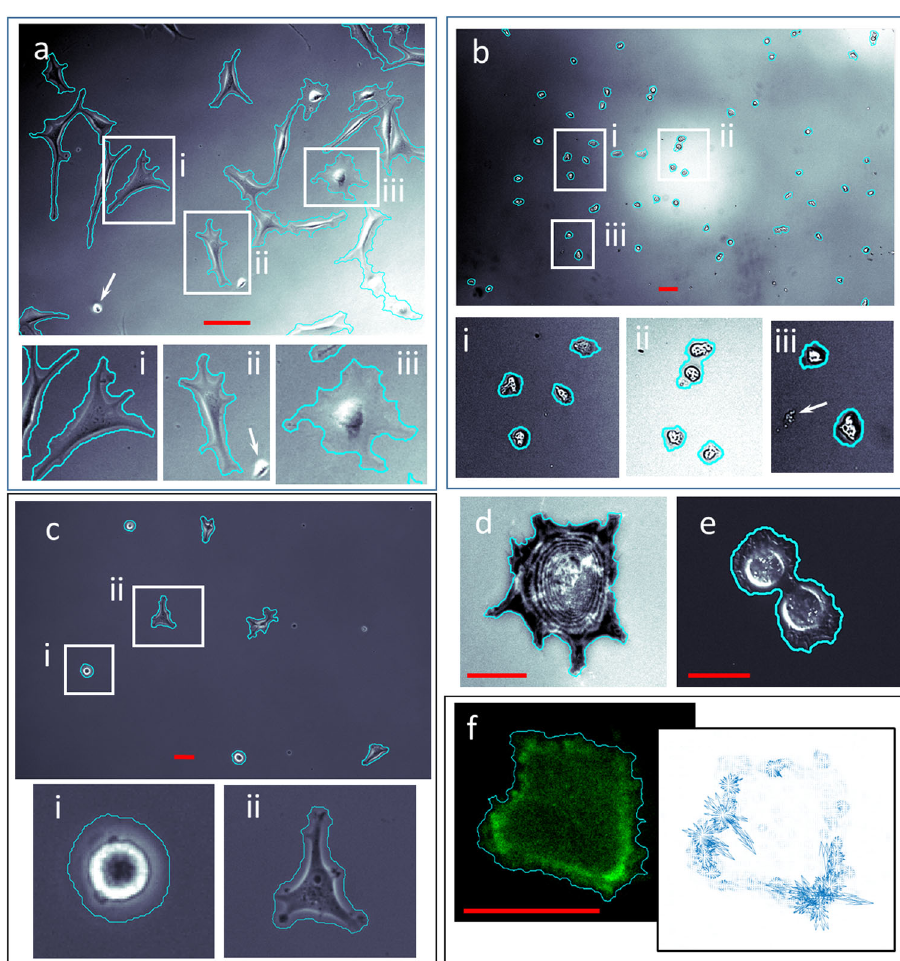
Fig. 3 Self-supervised segmentation for a range of cell types, microscope modalities, time resolutions and magni fi cations. a phase contrast of Hs27 fi broblasts (10X objective, time increment: 1200 s) b transmitted light of Dictyostelium (10X objective, time increment: 60 s) c phase contrast of MDA- MB-231 (10X objective, time increment: 600s) d IRM image of a single Hs27 cell (40X objective, time increment: 600 s). e DIC image of